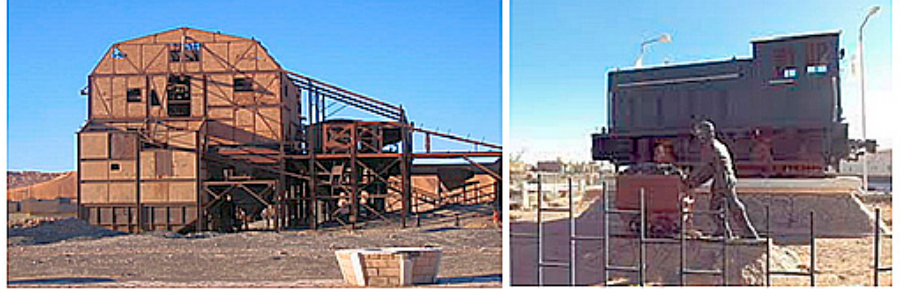
Figure 8. Coal mine in Kenadza (Béchar).